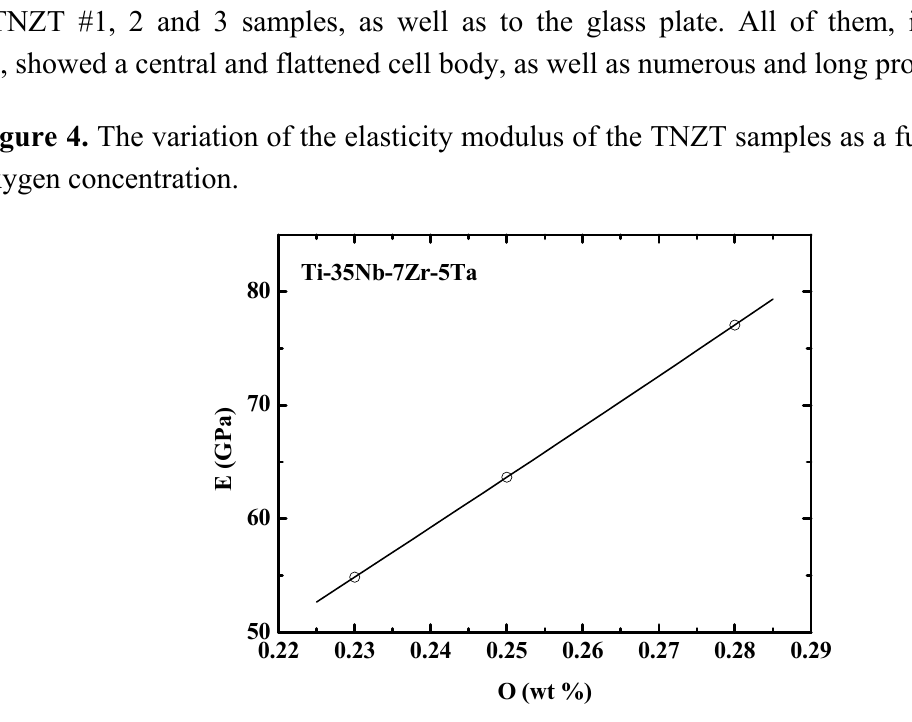
Figure 5. Evolution of the cytotoxicity of TNZT alloy doped with three amounts of oxygen. ( a ) Direct and ( b ) indirect MTT (3-(4,5-dimethyl-2-thiazolyl)-2,5-diphenayl-2H- tetrazolium bromide); NC (negative control); (1) the TNZT #1 sample; (2) the TNZT #2 sample; and (3) the TNZT #3 sample and PC (positive